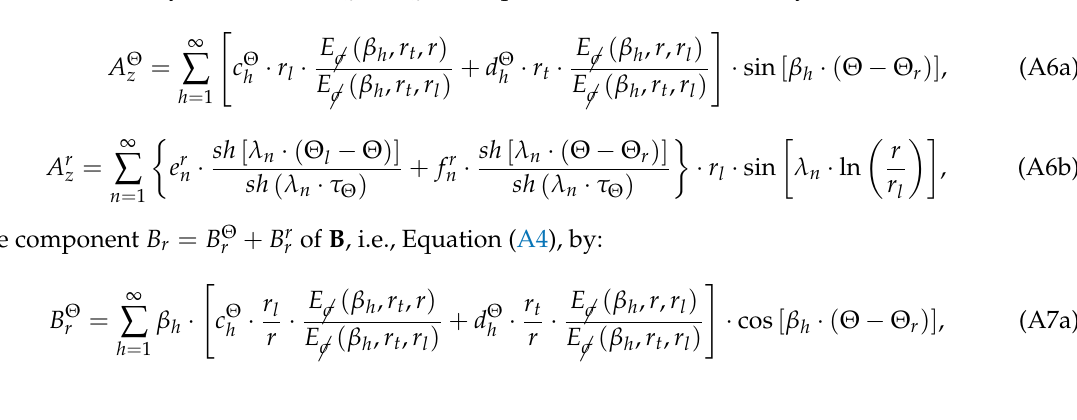
Figure A1. A z imposed on all edges of a region: ( a ) general and ( b ) principle of superposition. In Case-Study No. 1, A z = A